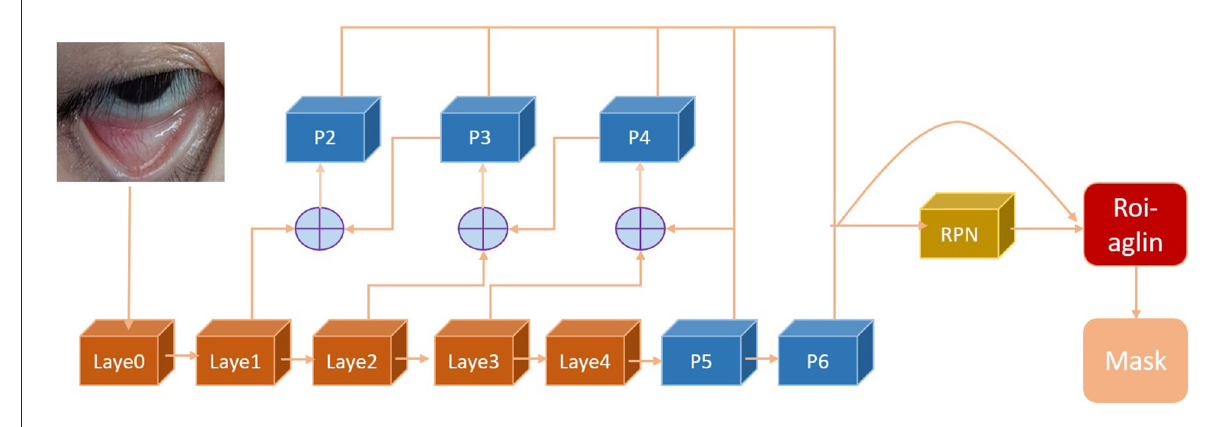
FIGURE3 Flow chart of palpebral segmentation network.